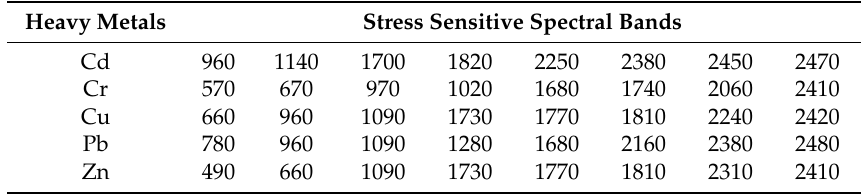
Table 2. Stress sensitive spectral bands of the five pollution heavy metals